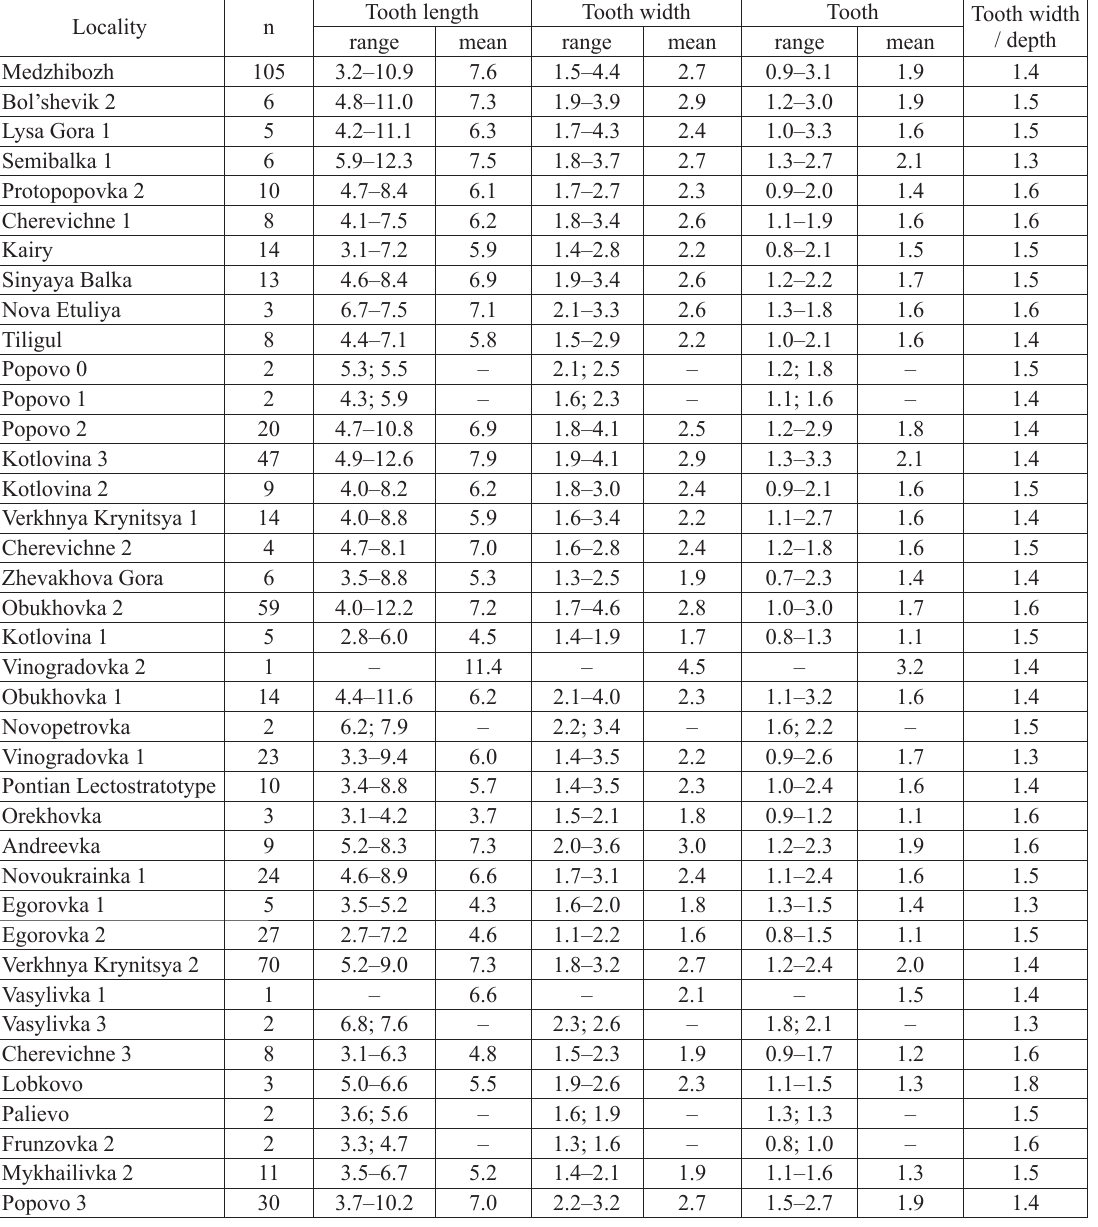
Table 4. Measurements (in mm) of jaw teeth of pikes ( Esox sp.) from the Mio-Pleistocene of southeastern Europe. N, number of specimens. Tooth length Tooth width Tooth Tooth width Locality n